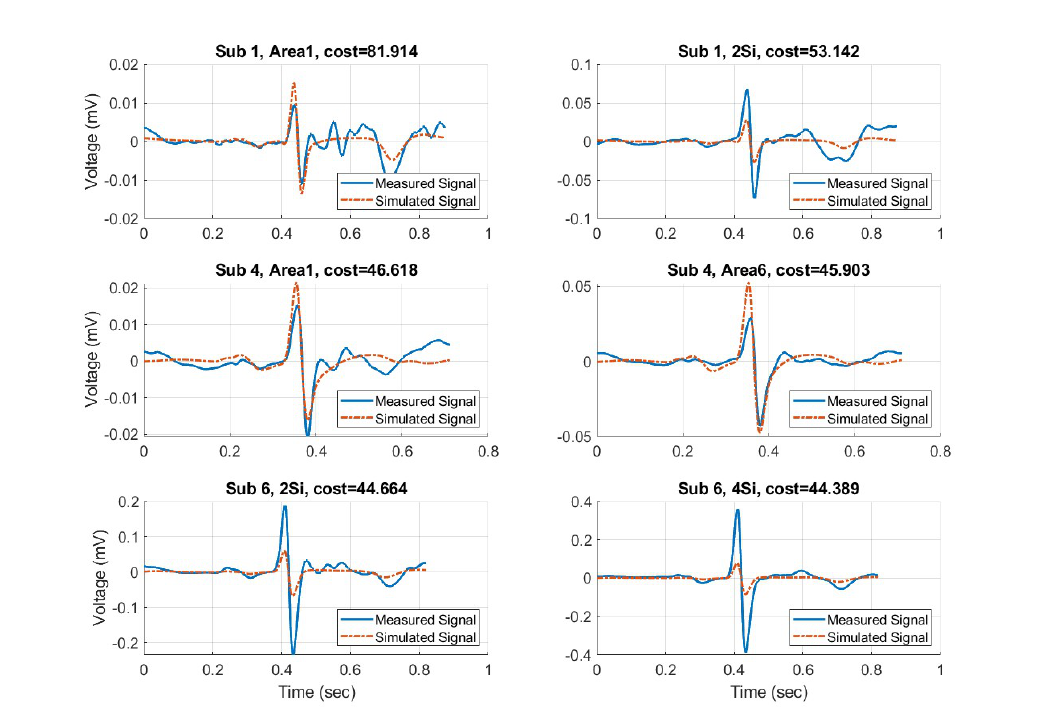
Figure 12. The 6 worst fit simulated waveforms with their corresponding measured